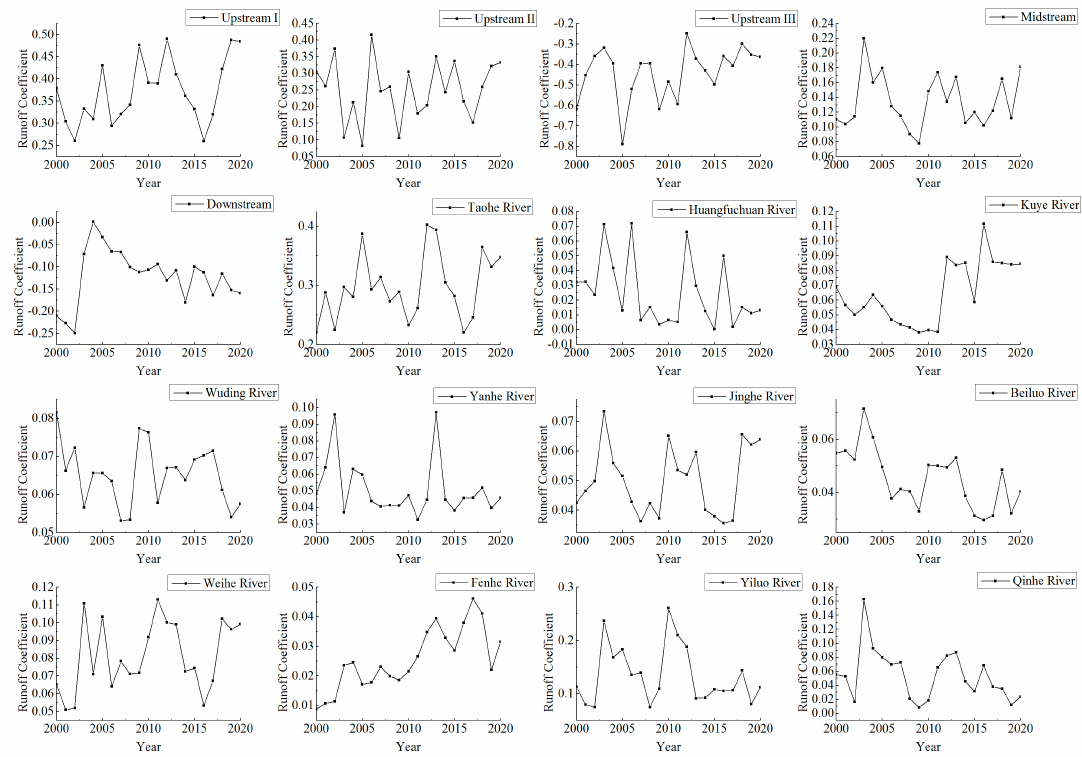
Figure 7. Changes in the runoff coefficients of the main stream and tributaries of the Yellow River basin; this figure includes the change in runoff coefficients in each division of the main and main